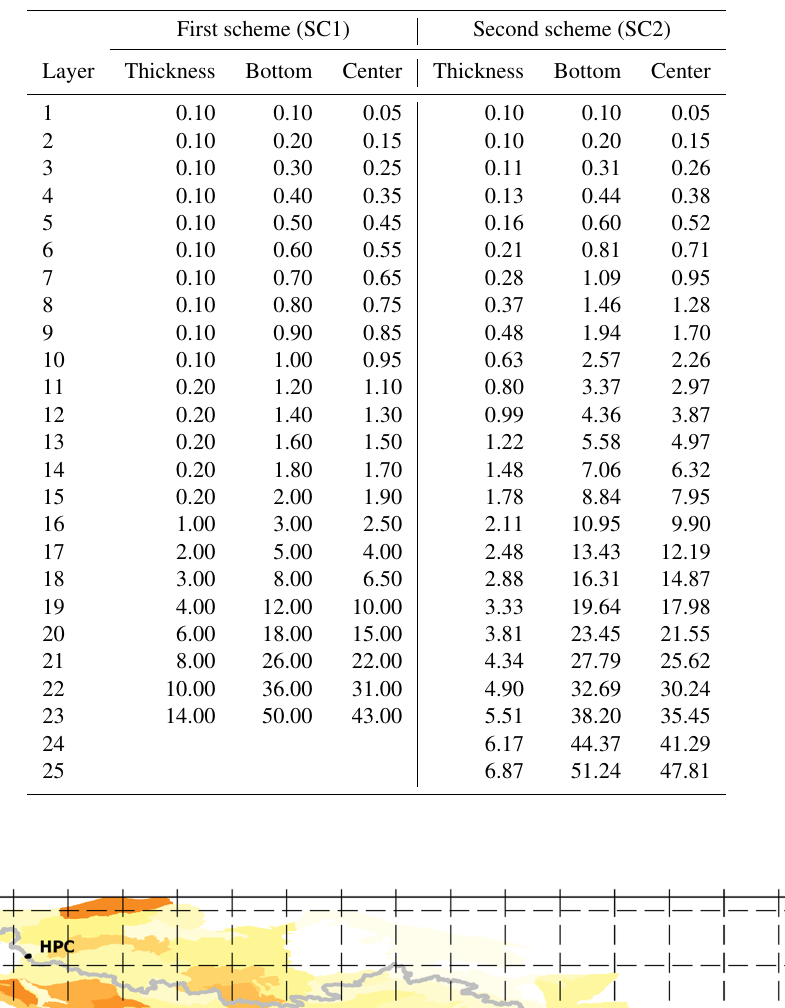
Table 2. Soil profile layering schemes.